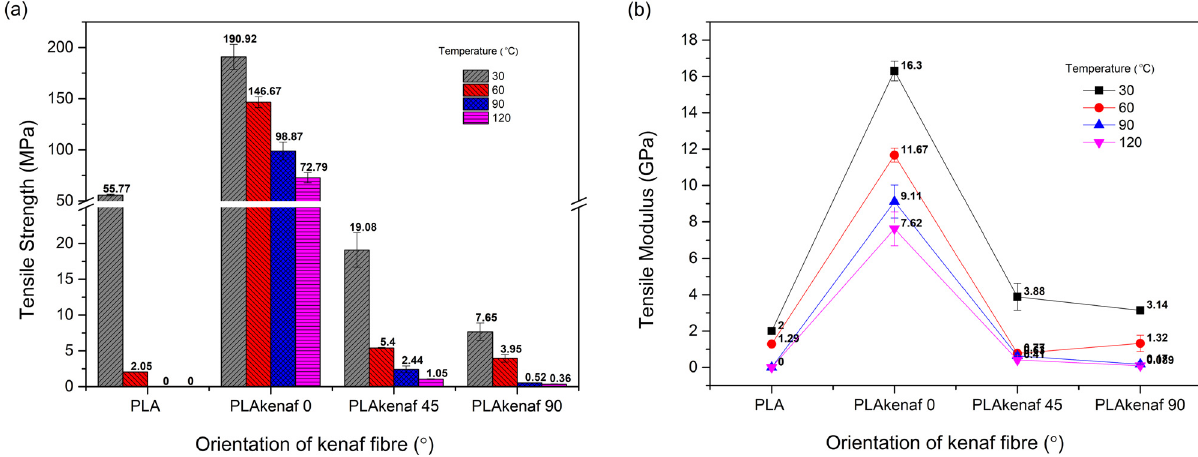
Figure 6: ( a ) Tensile strength and ( b ) Young ’ s modulus of pure PLA and PLA – kenaf composites at di ff erent